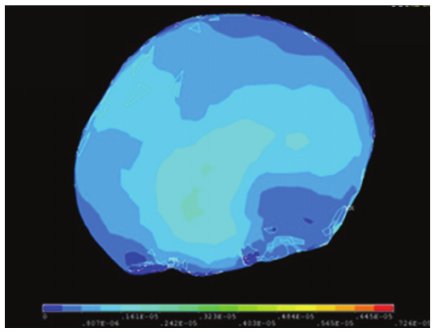
Figure 22: Strain graph when the ICP is 3.0 kPa.